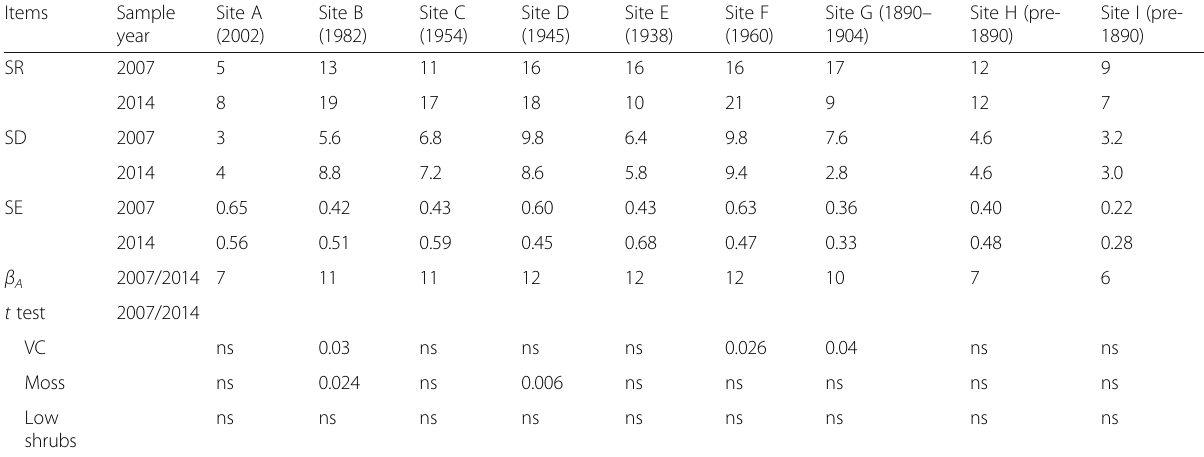
Table 3 Statistical analyses of species data